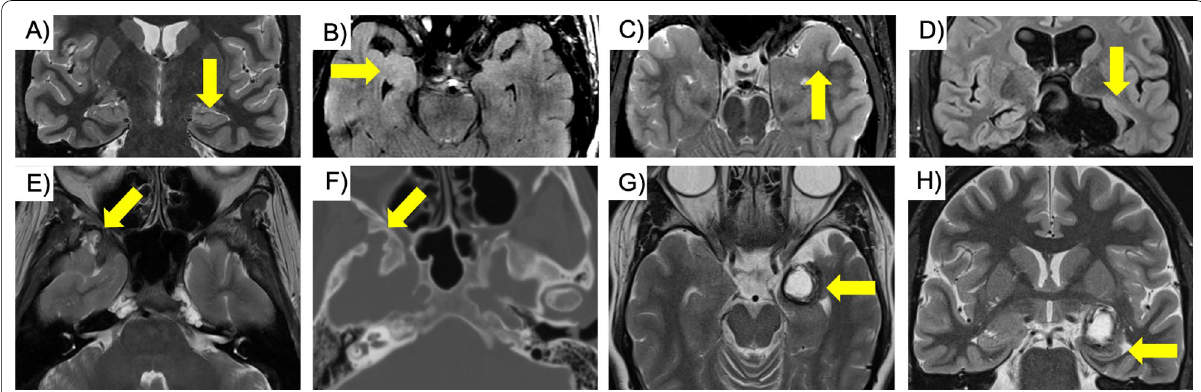
Fig. 3 Temporal lobe findings. a Subtle sign of left sided MTS with loss of the interdigitations of the pes hippocampi (arrow). b Right sided isolated enlargement of the amygdala (arrow). c White matter abnormality in the anterior left temporal lobe (arrow). d Suprasellar arachnoid cyst with compression of the left hippocampus (arrow). e Right temporopolar encephalocele with herniation of brain parenchyma (arrow) through a bony defect in the sphenoid ( f , arrow, same patient as e ). g Left sided MCA aneurysm with lamellated onion skin appearance (arrow) resulting in inferior displacement and compression of the left hippocampus ( h , arrow, same patient as g